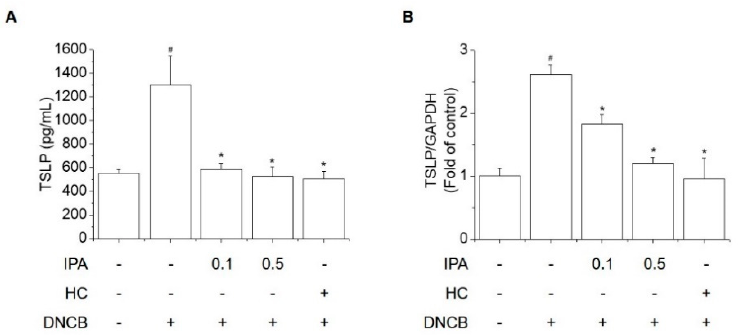
Figure 3. Inhibitory effect of IPA on the DNCB-induced increased serum concentration and mRNA level of thymic stromal lymphopoietin (TSLP) in BALB/C mice. ( A ) Serum TSLP concentrations were assessed by ELISA. ( B ) TSLP mRNA level was assessed by real-time PCR. Results are means ± SD (n = 6). # p < 0.05, versus the control group; * p < 0.05, versus the DNCB-treated group.